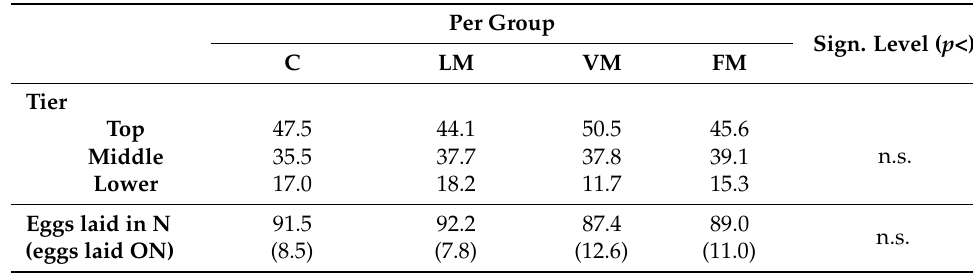
Table 3. Egg distribution (expressed as a percentage of counted eggs) in terms of nest use (N = nest or ON = outside nest), across the tiers on the aviary (top, middle and lower tier) and across the experimental groups (C = Control, LM = Longitudinal Movement, VM = Vertical Movement, FM= Freedom of